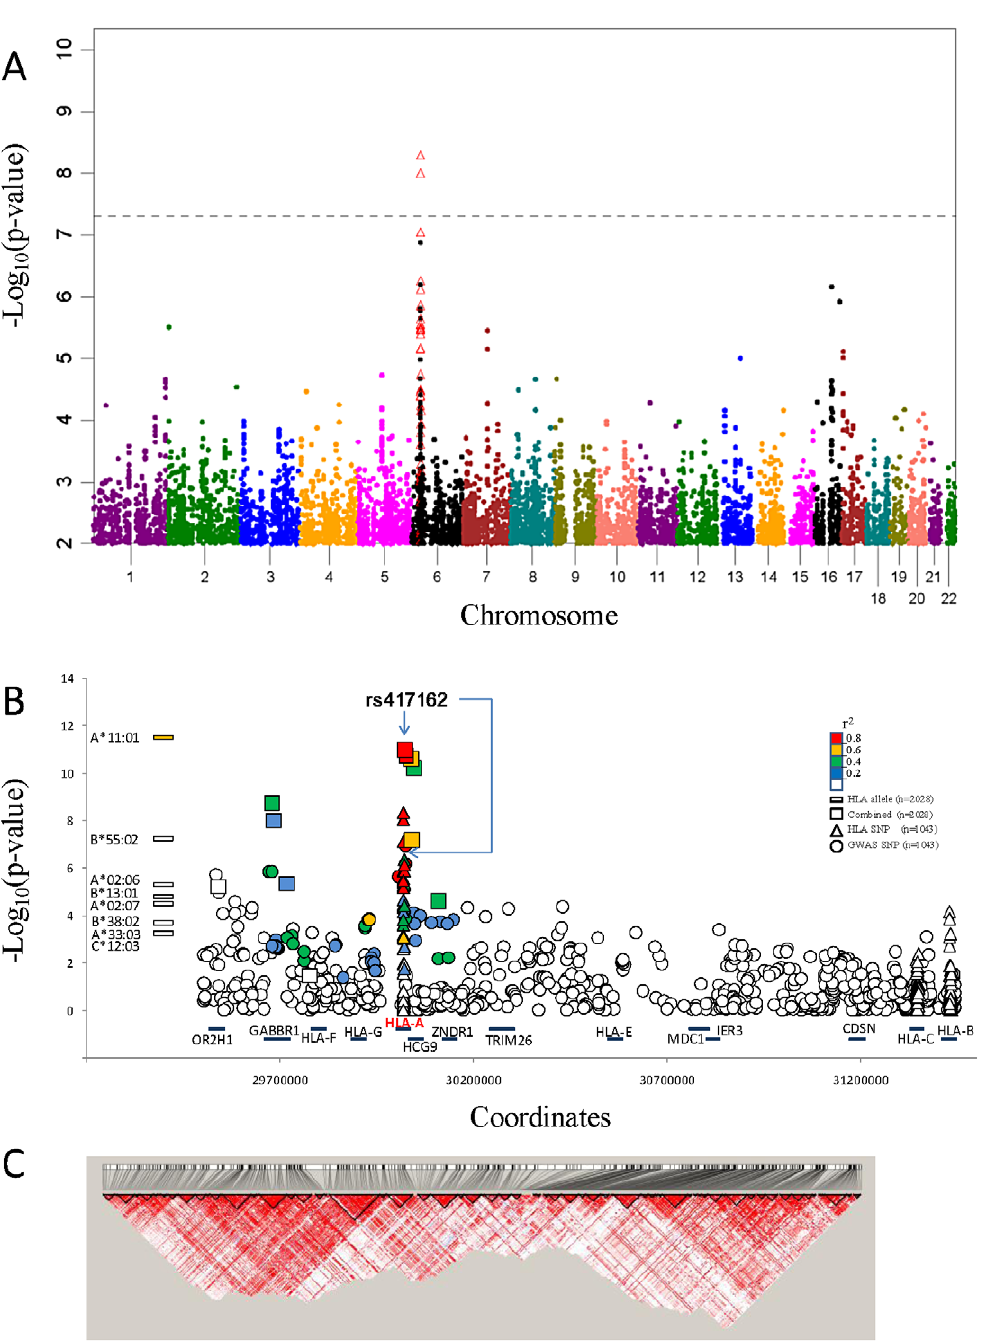
Figure 1. NPC associations of GWAS and Taqman validation. A.) Manhattan plot of GWAS P value association results of 591,458 SNP allele genotypes versus chromosome coordinate position ( N =1043 study participants; Row I in Table S3). Association p-values (-log 10 transformed) are calculated by logistic regression in additive logistic model and plotted by genomic position. Association p-values for HLA SNP that were assessed by HLA sequence base typing for the same 1043 individuals are indicated by open red triangles (see text). B.) NPC association signal for significant HLA alleles (left) and included SNP variants on Chromosome 6.The –log 10 p values, calculated with the logistic regression model, in GWAS and combined association tests are shown, SNPs are ordered according to the location on chromosome 6 HLA-A region. Color coded indicate the LD value (r 2 ) of each variant with the most significant SNP rs417162. C.) Disequilibrium coefficient values for SNPs genotyped in the HLA region for NPC GWAS (N=1043), generated with the use of Haploview